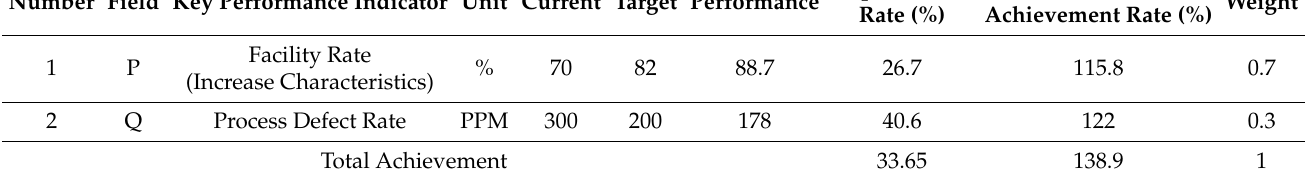
Table 4. The KPI evaluation